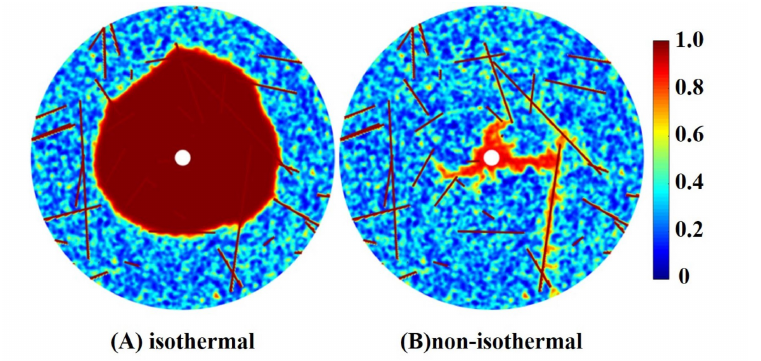
Figure 9. Comparison of dissolution structures for non-isothermal and isothermal cases in radial acidizing